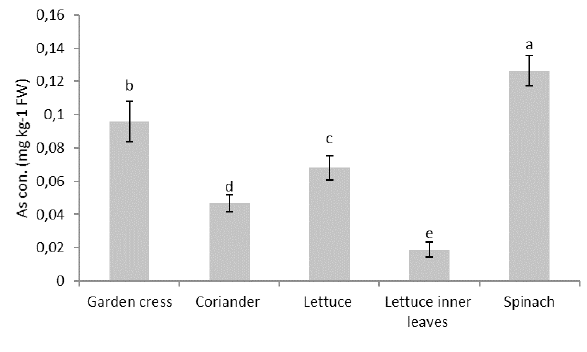
Figure 2: Lead concentration of foliages in different vegetable crops irrigated using wastewater. Bars represent averages of five replica- tes ± SD. Bars with same letter are not significantly different at 5% level of Duncan test